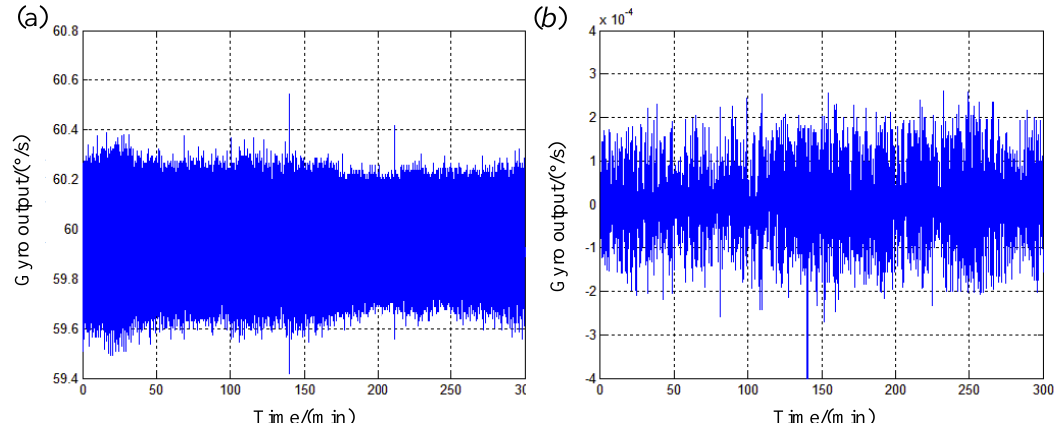
Figure 12. Gyro outputs for calculating ARW. ( a ) Original gyro outputs; ( b ) Gyro outputs after pre-processing.